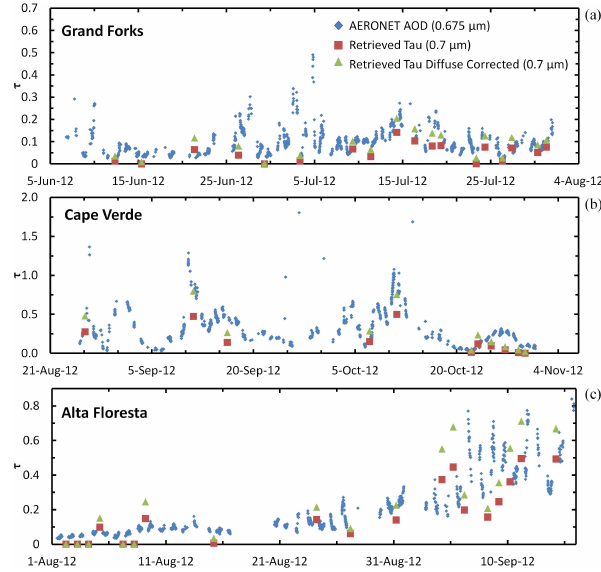
Fig. 5. (a) Time series for Grand Forks showing AERONET τ , and VIIRS-retrieved τ ignoring the diffuse transmission of light ( k = 1) and using the 6S urban aerosol model to estimate k . (b) Similar to Fig. 5a except for Cape Verde and using the 6S desert aerosol model to estimate k . (c) Similar to Fig. 5a except for Alta Floresta and using the 6S biomass burning aerosol model to estimate k